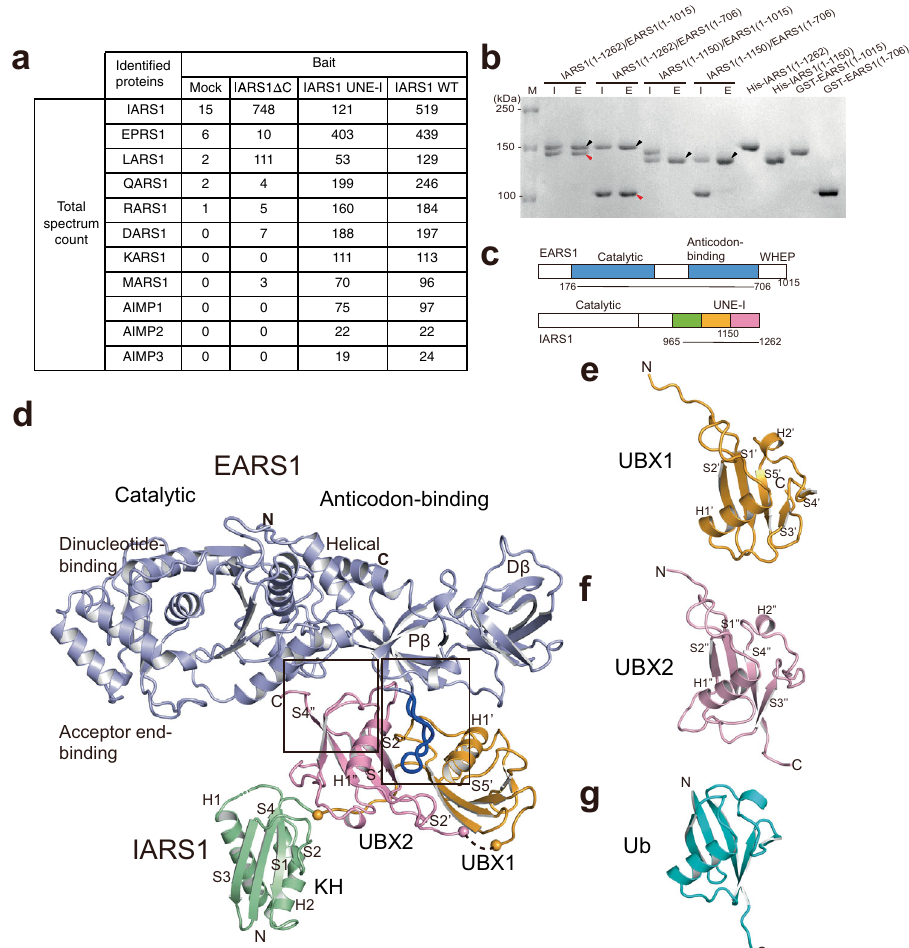
Fig. 1 | Overall structure of the EARS1 – IARS1 complex. a A list of MSC compo- nentsidenti fi edbymassspectrometry.Totalspectrumcountofidenti fi edproteins interacting with IARS1 Δ C, IARS1 UNE-I, or IARS1 WT is shown. b Af fi nity pull-down analysis of the interaction between EARS1 and IARS1. The input (I) and eluate (E) fractions were analyzed by SDS-PAGE and Coomassie Blue staining. Black and red arrowheads indicate eluted His-IARS1 and GST-EARS1, respectively. The data are